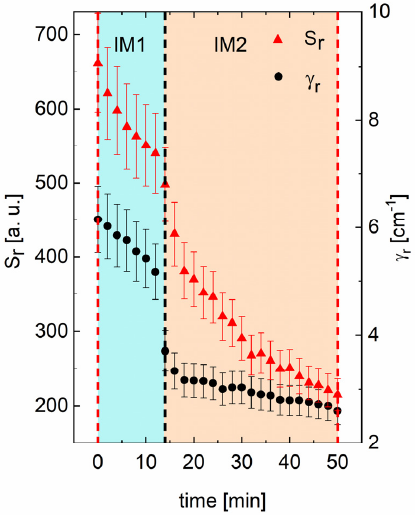
Figure 7. Strength S r (triangles) and relaxation rate γ r (circles) of the central peak as a function of time for PbZrO 3 :0.1Nb crystal at 233 °C. The black dashed line corresponds to the isothermal phase transition. The red dashed lines correspond to the measurement time marked with the red line at 233 °C in Figure 4.